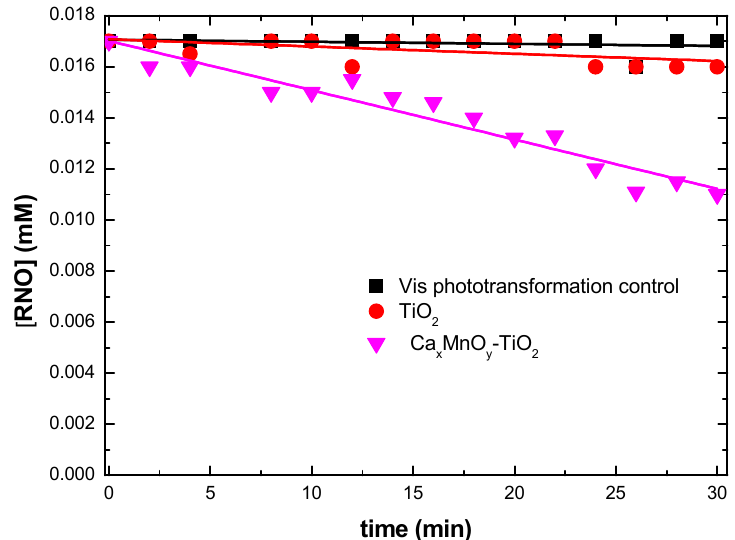
Figure 11. HO • detection by means of RNO bleaching under visible-only irradiation for Ca x MnO y -TiO 2 , TiO 2 and visible-only transformation control. This was achieved by using a cut o ff filter to block the UV radiation with λ < 410 nm.